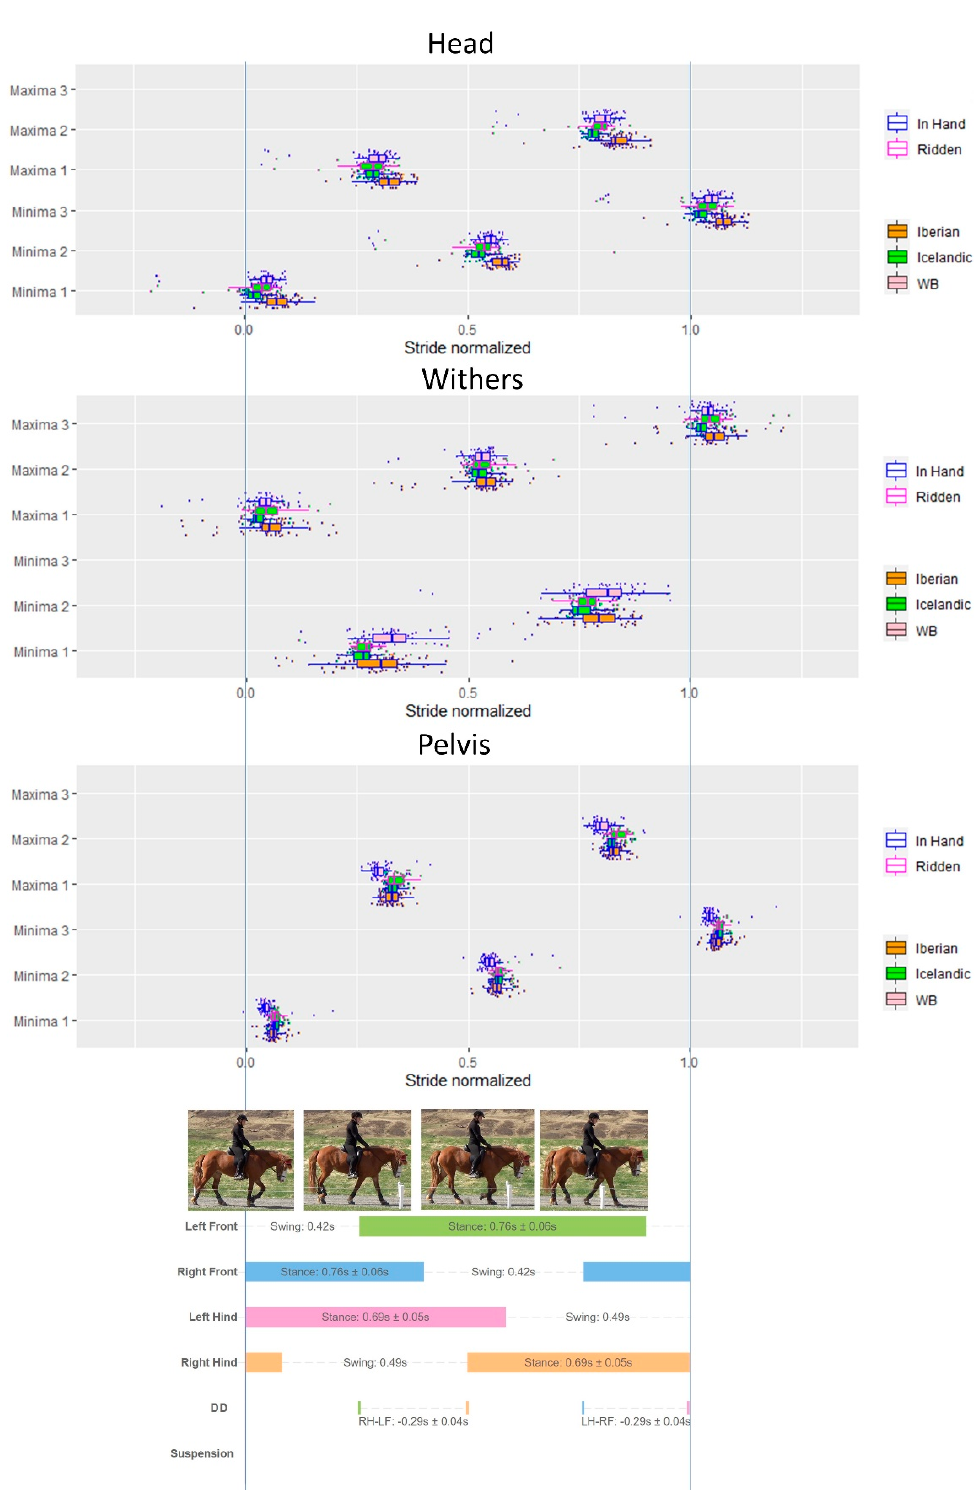
Figure 3. Combined data for the three breeds (Iberian, Icelandic, Warmblood) to show timing of minima (Min) and maxima (Max) on y-axis of the head, withers and pelvis during a normalized walk stride, including data from in hand and ridden conditions. Each dot represents a stride. Stance bars for each limb indicate mean and standard deviation (SD) of all strides across breeds and conditions. Diagonal dissociation (DA) and SD for right hindlimb (RH)–left forelimb (LF) diagonal and left hindlimb (LH)–right forelimb (RF) diagonal are presented.